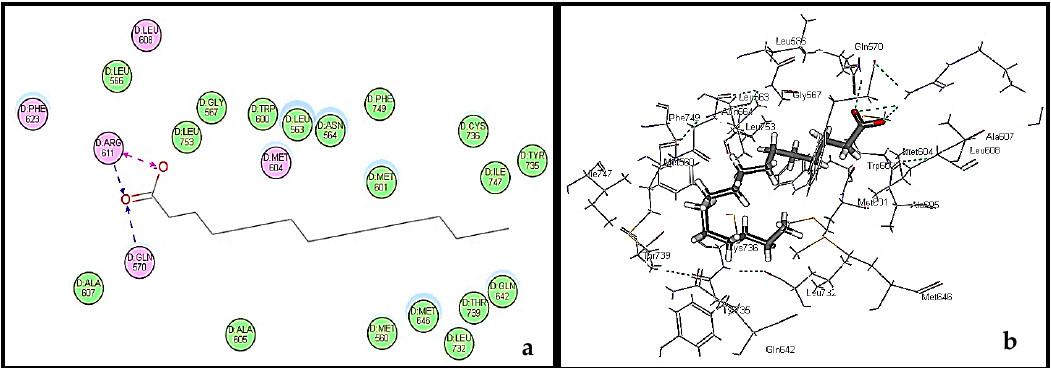
Figure 5. 2D binding mode ( a ) and 3D binding mode ( b ) of palmitic acid in the active site of human glucocorticoid receptors (GR).